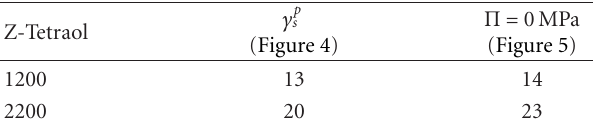
Table 2: Monolayer thicknesses for Z-Tetraols on CN x ( ˚A).